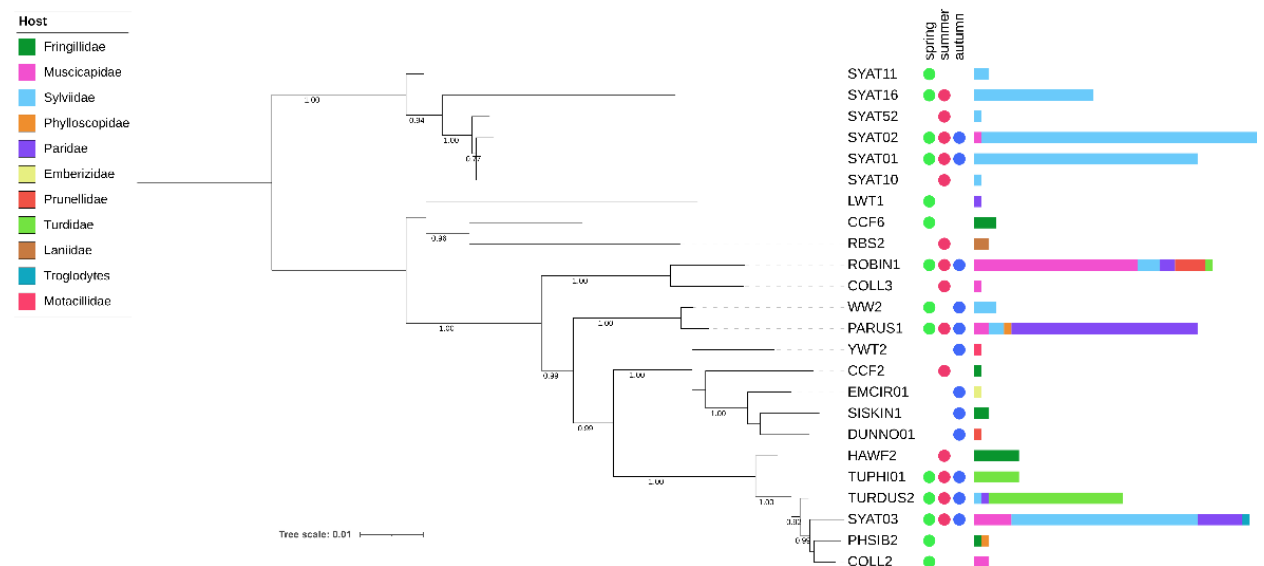
Figure 2. Maximum likelihood tree of avian haemoproteid lineages detected at the study site in Slovakia based on a 1516 bp mtDNA region encompassing the cytb gene. The tree was constructed based on the best-fit substitution model (TIM2 + F + I + G4) and is rooted at midpoint. The branch support was assessed using the aBayes test, and the corresponding values are shown for branches >75% support. After each lineage, circles denote the seasonal dynamics of the lineage’s occurrence and horizontal bars denote the lineage’s abundance in their avian hosts of 11 families.